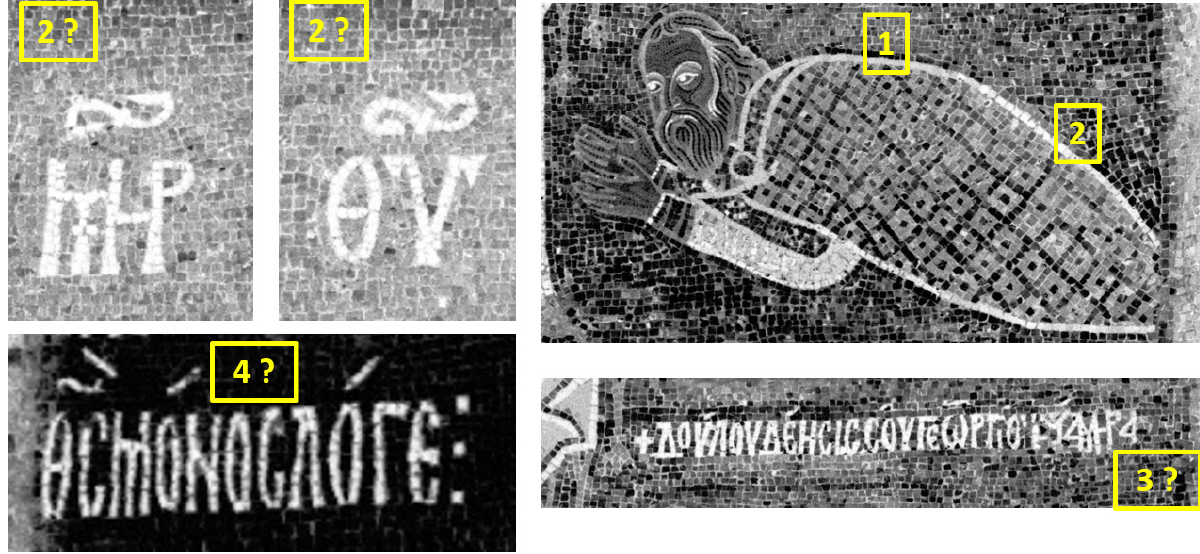
Figure 9: Palermo, St. Mary of the Admiral, Dedication panel: three different images of Giorgio a) visible image; b) IR (720 nm) calibrated image; c) IR (850 nm) filtered image with histogram